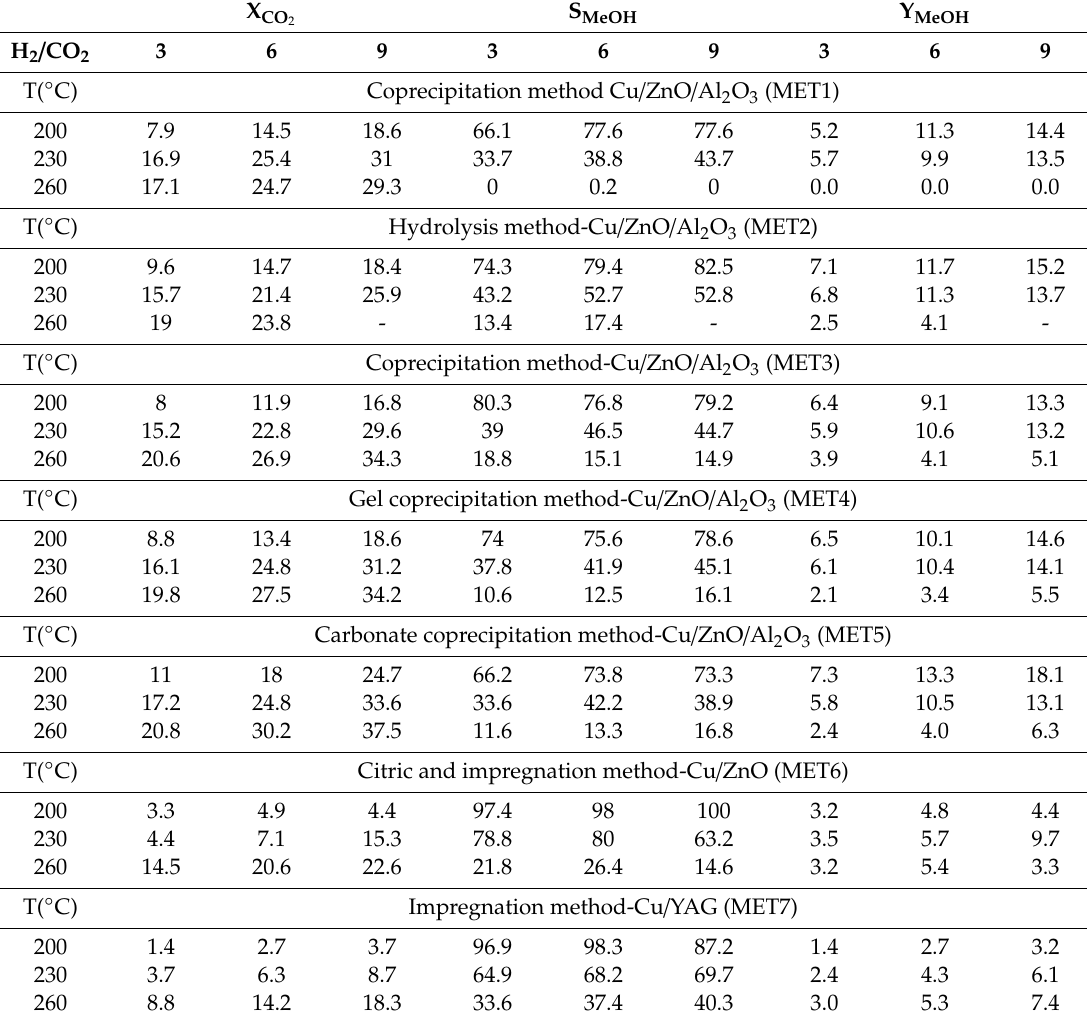
Table 2. Screening and comparative performance analysis of the catalysts (P = 10 bar and gas hourly space velocity (GHSV) = 684 h − 1 ).